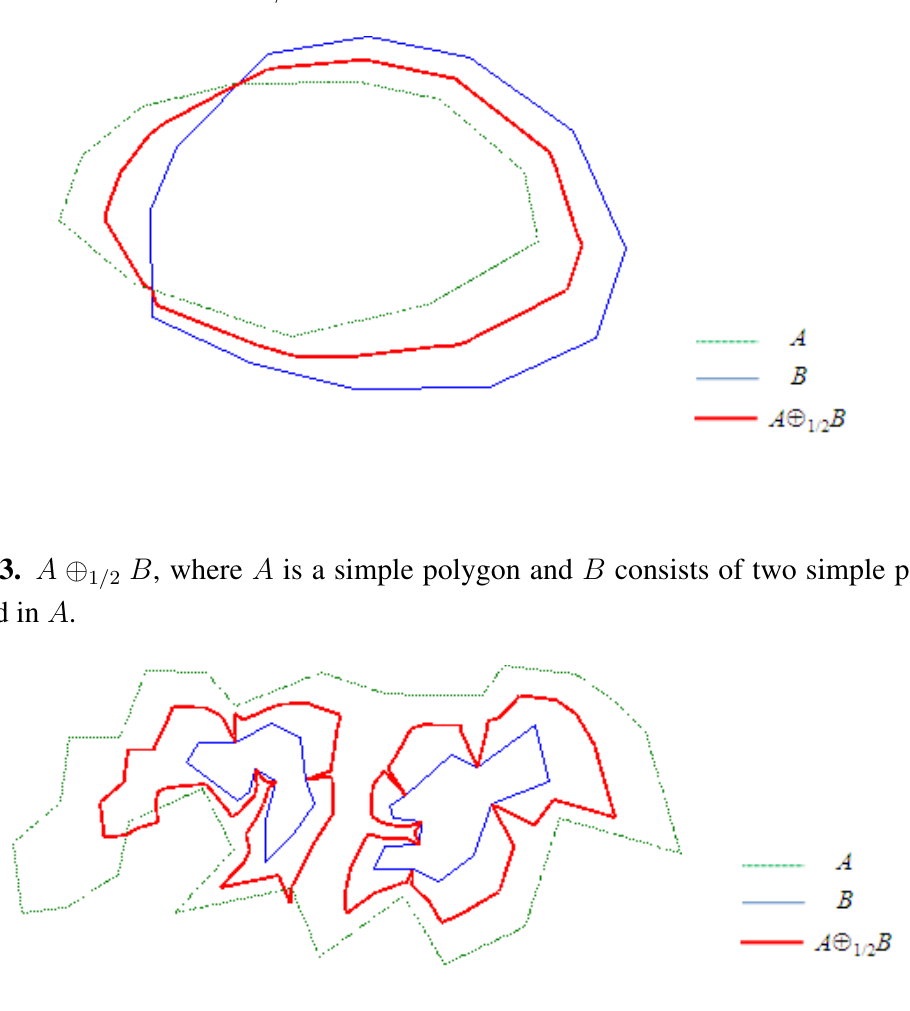
B where A, B are simple convex polygons. Figure 2. A ⊕ 1 / 2